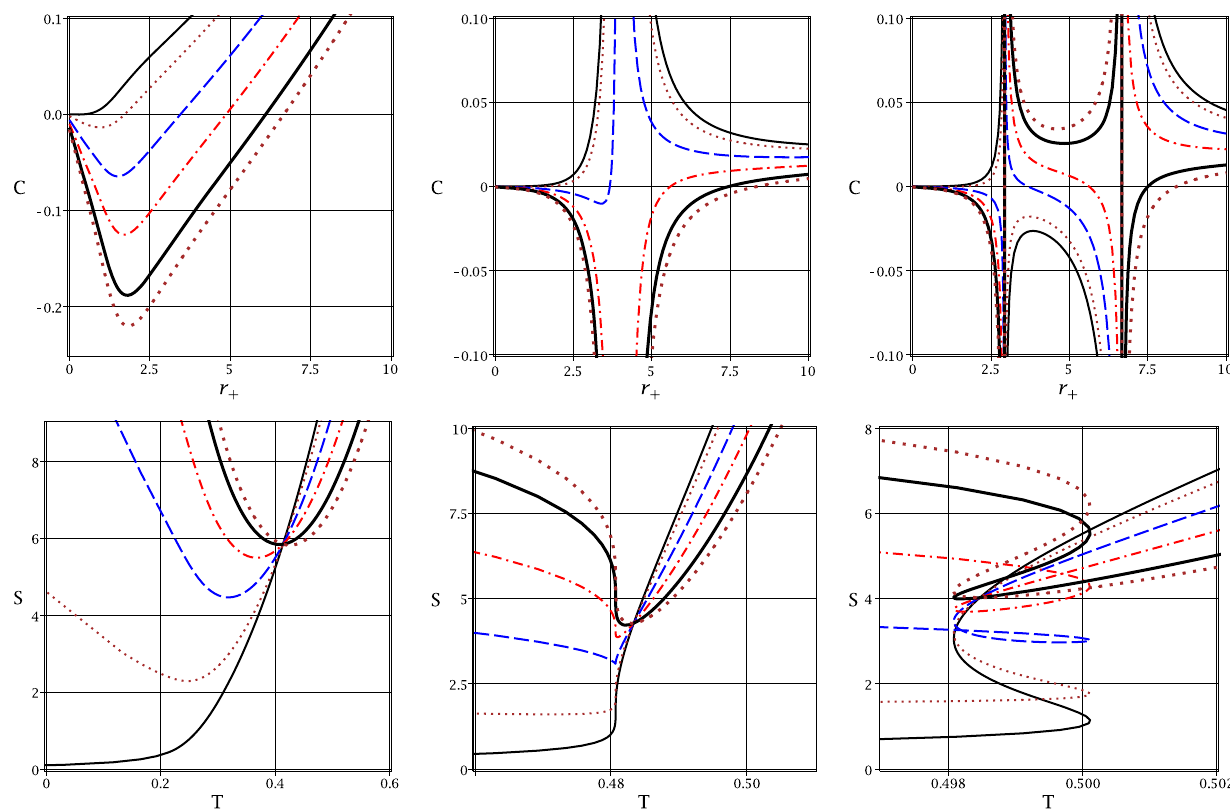
Fig. 4 C versus r + (uppanels)and S versus T (lowerpanels)for k = 1, m = 5, (cid:16) = − 1, b = 1, q = 1, β = 1, f (ε) = g (ε) = 0 . 9, ζ = 0 (continuous line), ζ = 1 (dotted line), ζ = 3 (dashed line), ζ = 5